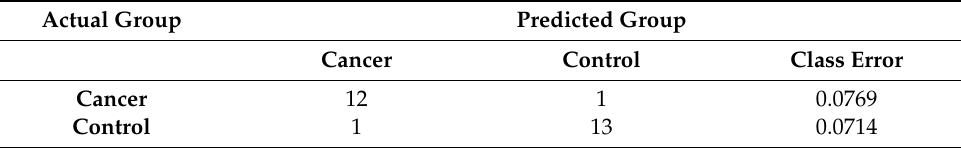
Table 3. Random forest prediction accuracy applied on the testing set made from 20% of cases and controls ( n = 27, cancers = 13, controls = 14).